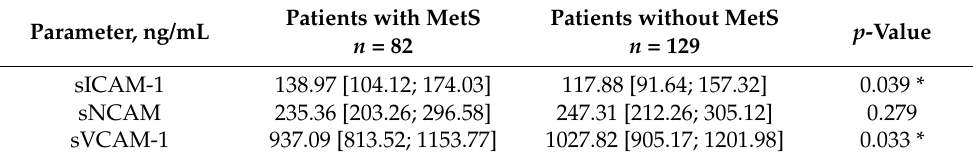
Table 2. Levels of CAMs in schizophrenia patients with or without MetS (Me [Q1; Q3]).